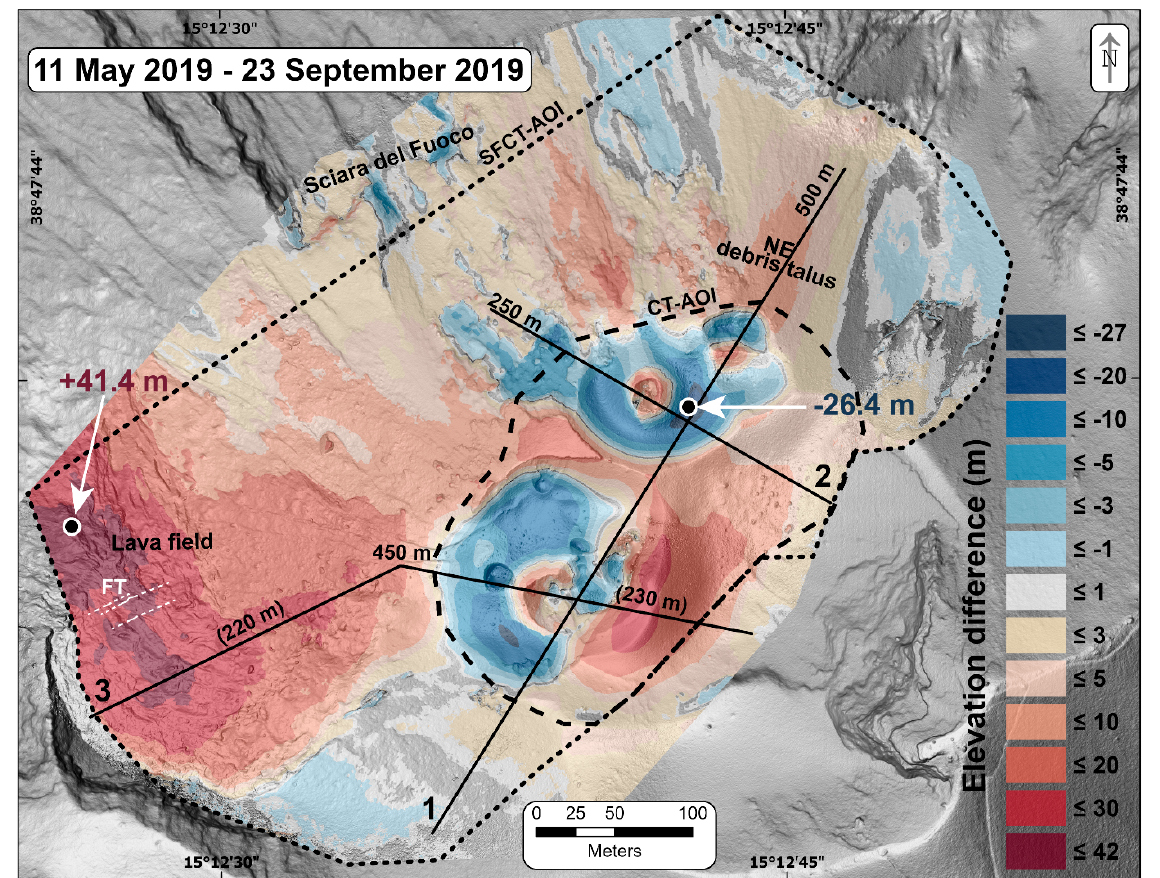
Figure 5. DEM of Difference (DoD) of the Stromboli summit area for the period May–September 2019 (pre- and post-2019 paroxysms). Black lines show the traces of the topographic profiles shown in Figure 6. Blue areas indicate material loss, whereas yellow/red areas indicate material gain. The black dots pinpoint the locus of maximum material gain and maximum material loss; the black dashed line encloses the common Area Of Interest of all surveys for the crater terrace (CT-AOI); the black dotted line encloses the common Area Of Interest of three surveys (May, August, and September 2019) for the crater terrace and upper SdF (SFCT-AOI); FT stands for “fratture Tibaldi” fissure swarm (white lines, see Discussion and Conclusions Section).